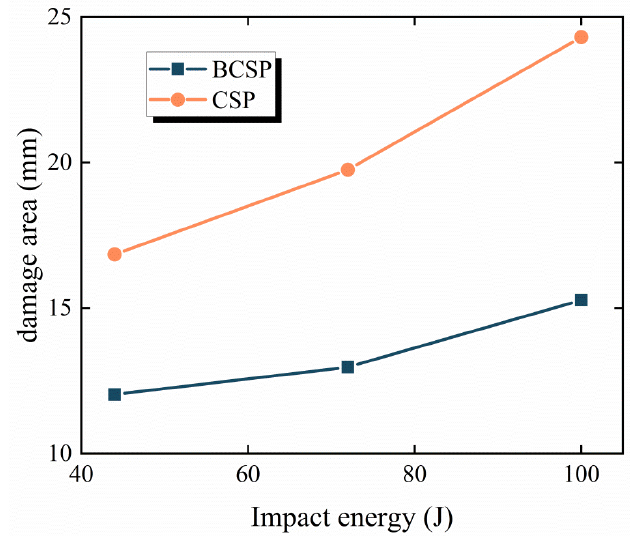
Figure 8. Comparison of the damage area between the BCSP and CSP under different impact energies.